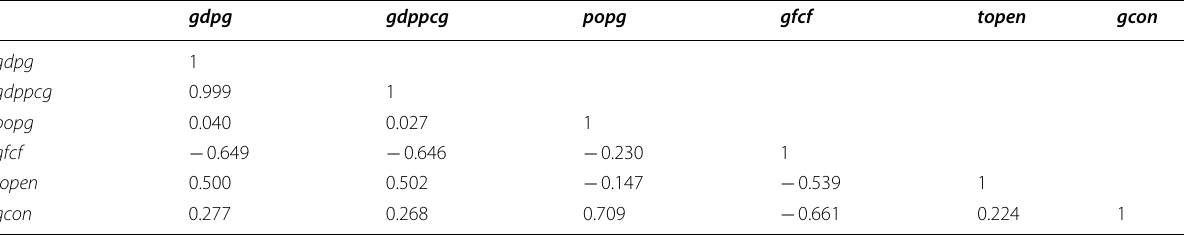
Table 2 Correlation matrix